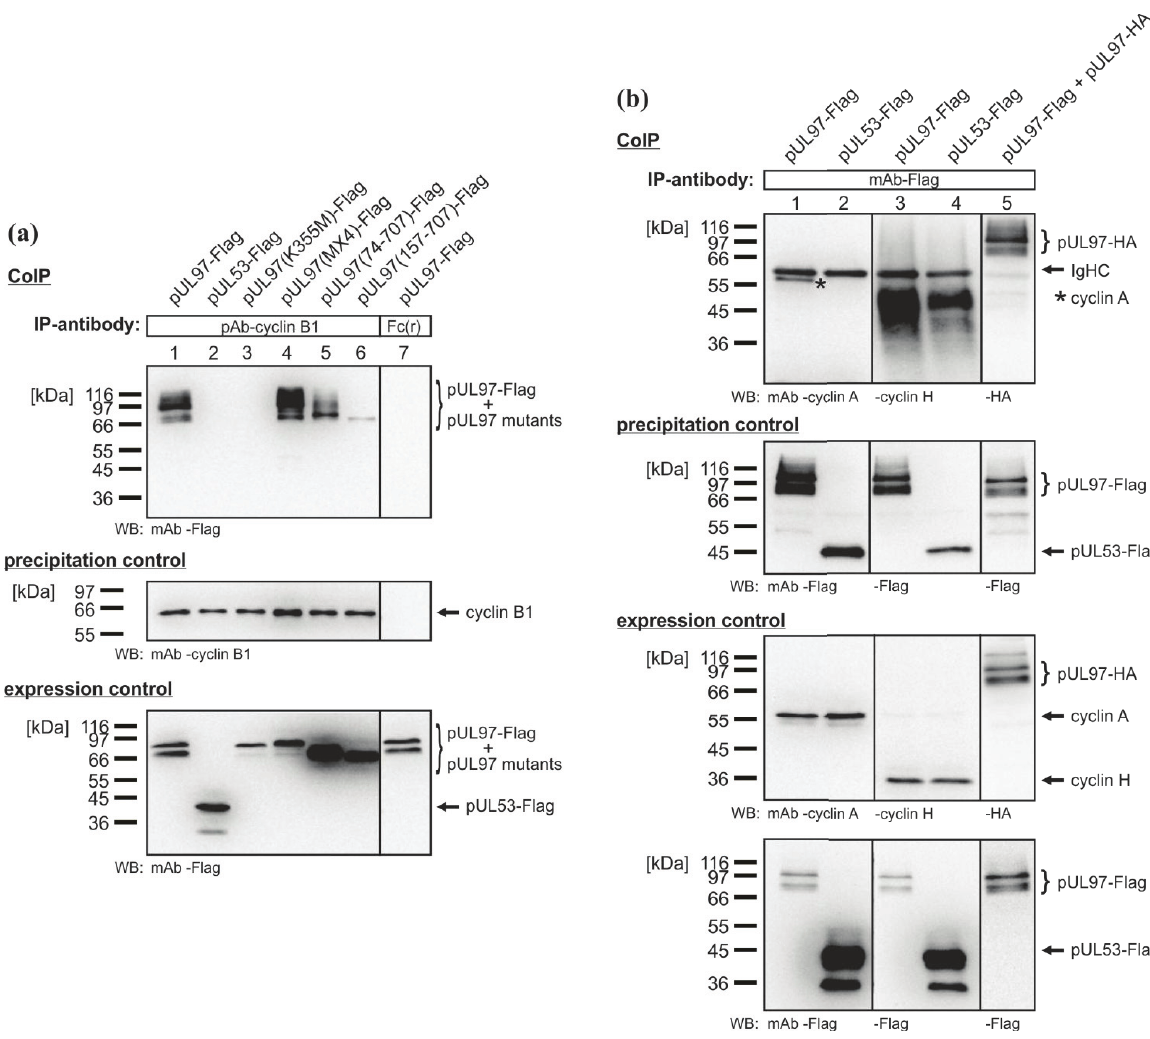
Figure 5. CoIP analyses used to reveal further cyclin interaction partners of pUL97. Flag-tagged amino acid replacement and deletion mutants of pUL97 were transiently expressed in 293T cells. At 2 days post-transfection, cells were lysed and used for co-immunoprecipitation analysis with ( a ) pAb-cyclin B1 (lanes 1 – 6) and the Fc fragments of rabbit antibodies as the control (Fc(r), Rabbit IgG Fc-Fragment, Jackson ImmunoResearch; lane 7), respectively; or with ( b ) mAb-Flag. CoIP analyses with recombinantly expressed pUL53-Flag ( a , lane 2; b , lanes 2 and 4) served as a negative control and the self-interaction of pUL97 as the positive control ( b , lane